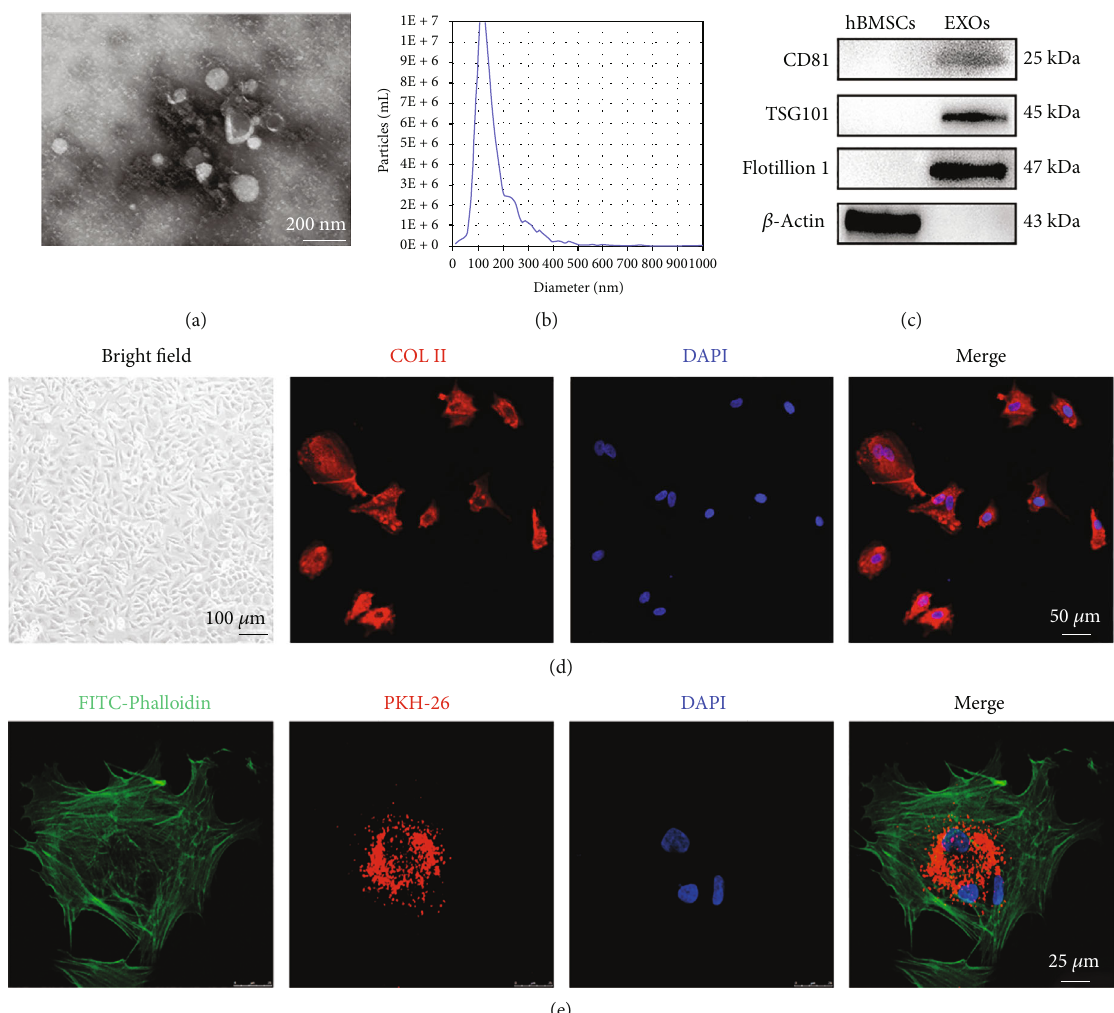
Figure 1: Characterization of human bone marrow stromal cell- (hBMSC-) derived exosomes (EXOs). (a) Representative transmission electron microscope (TEM) images of hBMSC-EXOs ( scalebar = 200nm ). (b) Nanoparticle tracking analysis for hBMSC-EXOs. (c) Western blots showing the exosome markers including CD81, TSG101, and Flotillin 1. β -Actin was used as a negative control. (d) Identi fi cation of rabbit chondrocytes. Cell morphology was observed at bright fi eld with a microscope ( scalebar = 100 μ m ). Collagen II (COL II; red) was analyzed by immuno fl uorescence. DAPI (blue) was used to designate the nuclei. Scalebar = 50 μ m . (e) Internalization of hBMSC-EXOs in primary rabbit chondrocytes. hBMSC-EXOs were labeled by PKH26 (red) and incubated with primary chondrocytes. FITC-Phalloidin (green) and DAPI (blue) were used to label the cytoskeleton and the nucleus, respectively. Scale bar = 25 μ m